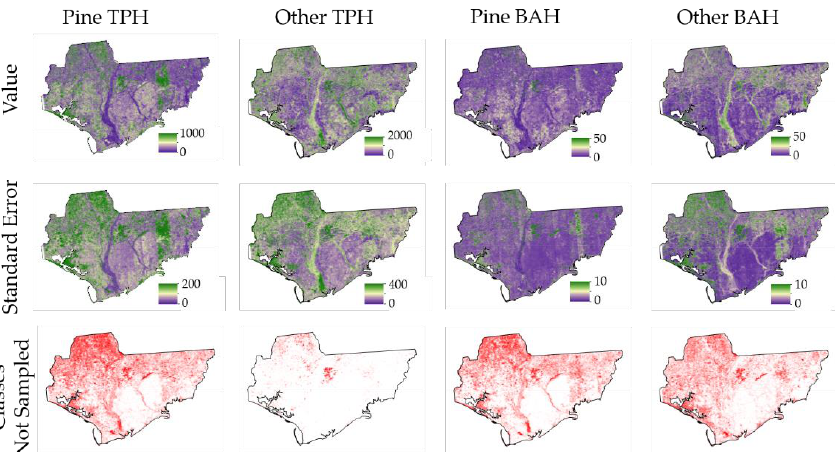
Figure 11. Display of trees per ha (TPH) and basal area per ha (BAH) raster surfaces created from ensemble generalized additive models (EGAMs) for Pine and Other tree species classes. EGAM raster cell estimated values (top row of graphics) and standard errors (middle row of graphics) increase as colors transition from purple to green. The spatial locations of k-mean classes not represented in the sample used to train EGAMs are displayed as red areas in the bottom row of